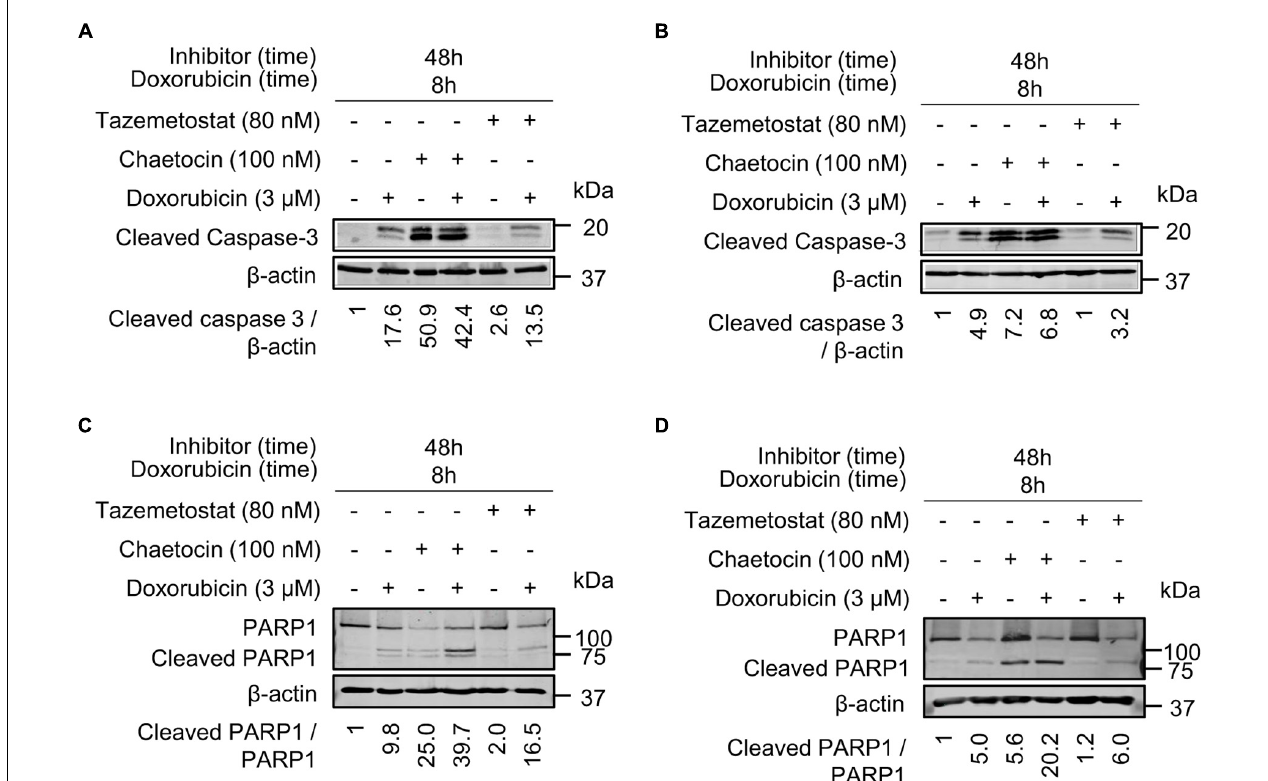
FIGURE 10 | Chaetocin and tazemetostat cause an activation of caspases detected by the processed caspase 3 and PARP1 in doxorubicin treated cells. Effect of chaetocin and tazemetostat on processed caspase 3 after treatment with doxorubicin in U2OS (A) and SK-LMS-1 (B) cells deprived of serum. Effect of chaetocin and tazemetostat on PARP1 cleavage after treatment with doxorubicin in U2OS (C) and SK-LMS-1 (D) cells deprived of serum. The cleavage of PARP1 in response to chaetocin is shown in Supplementary Figure 11